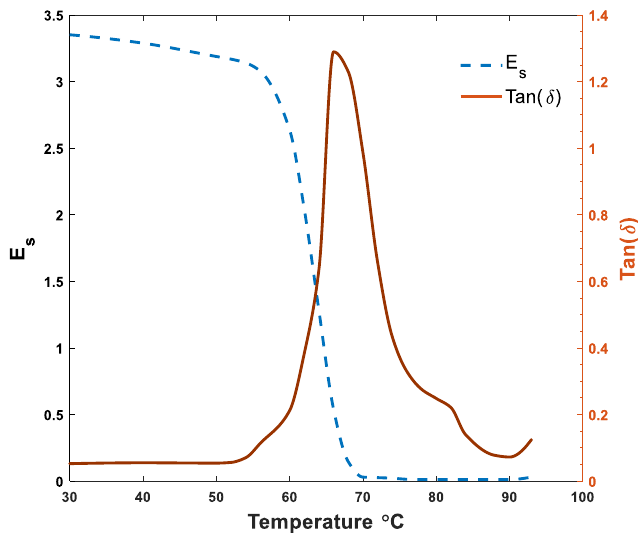
Figure 2. Dynamic-mechanical analyzer (DMA) test for the 3D-printed polylactic acid (PLA).